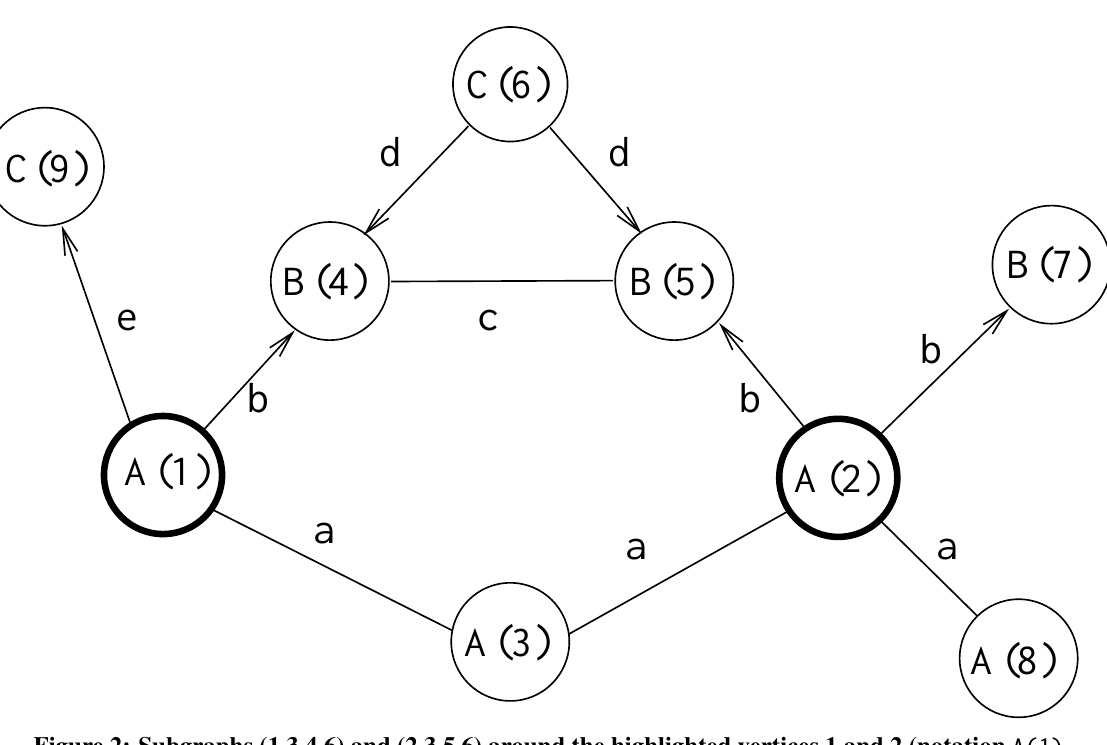
Figure 2: Subgraphs (1,3,4,6) and (2,3,5,6) around the highlighted vertices 1 and 2 (notation A(1) means that vertex 1 is of type A ) are isomorphic and partially overlapping. This results in